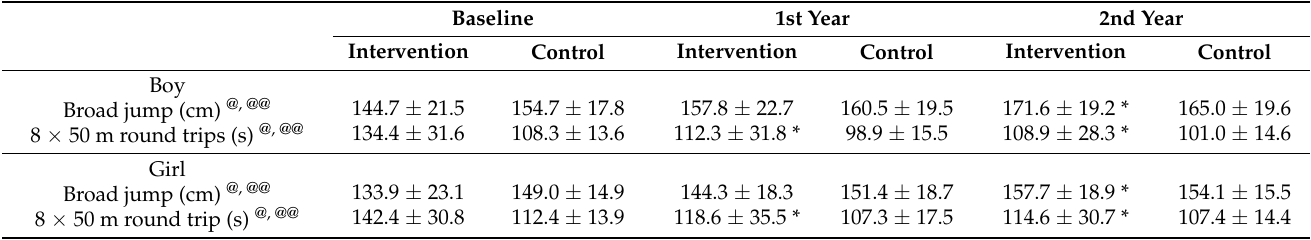
Table 6. Comparison of broad jump and 8 × 50 m round trip between intervention group at baseline, 1st year and 2nd year (means ± SDs). Baseline 1st Year 2nd Year Intervention Control Intervention Control Intervention